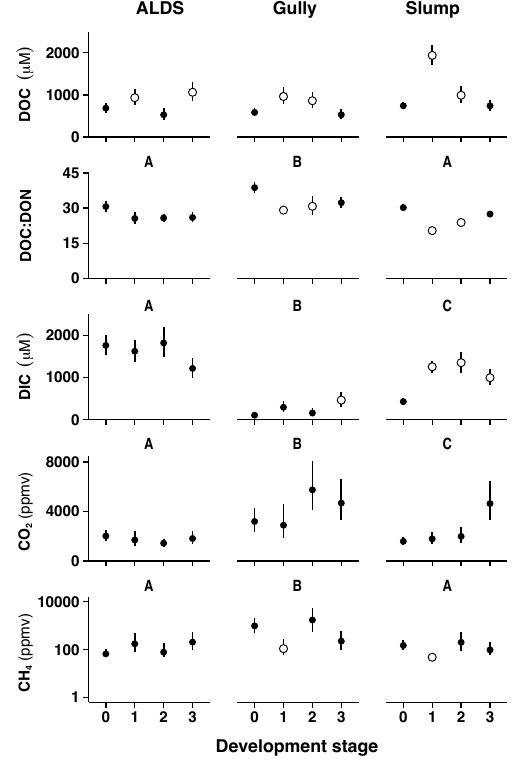
Figure 5. Nitrogen species and sulfate concentrations in outflow from 22 active-layer detachment slides, 19 thermo-erosion gullies, 42 thaw slumps, and 61 reference features. See Table 1 for complete definition of development stages: 0, reference; 1, most active; and 3, stabilized. Note log scales for NO − and NH + . Symbology the 3 4 same as Fig.